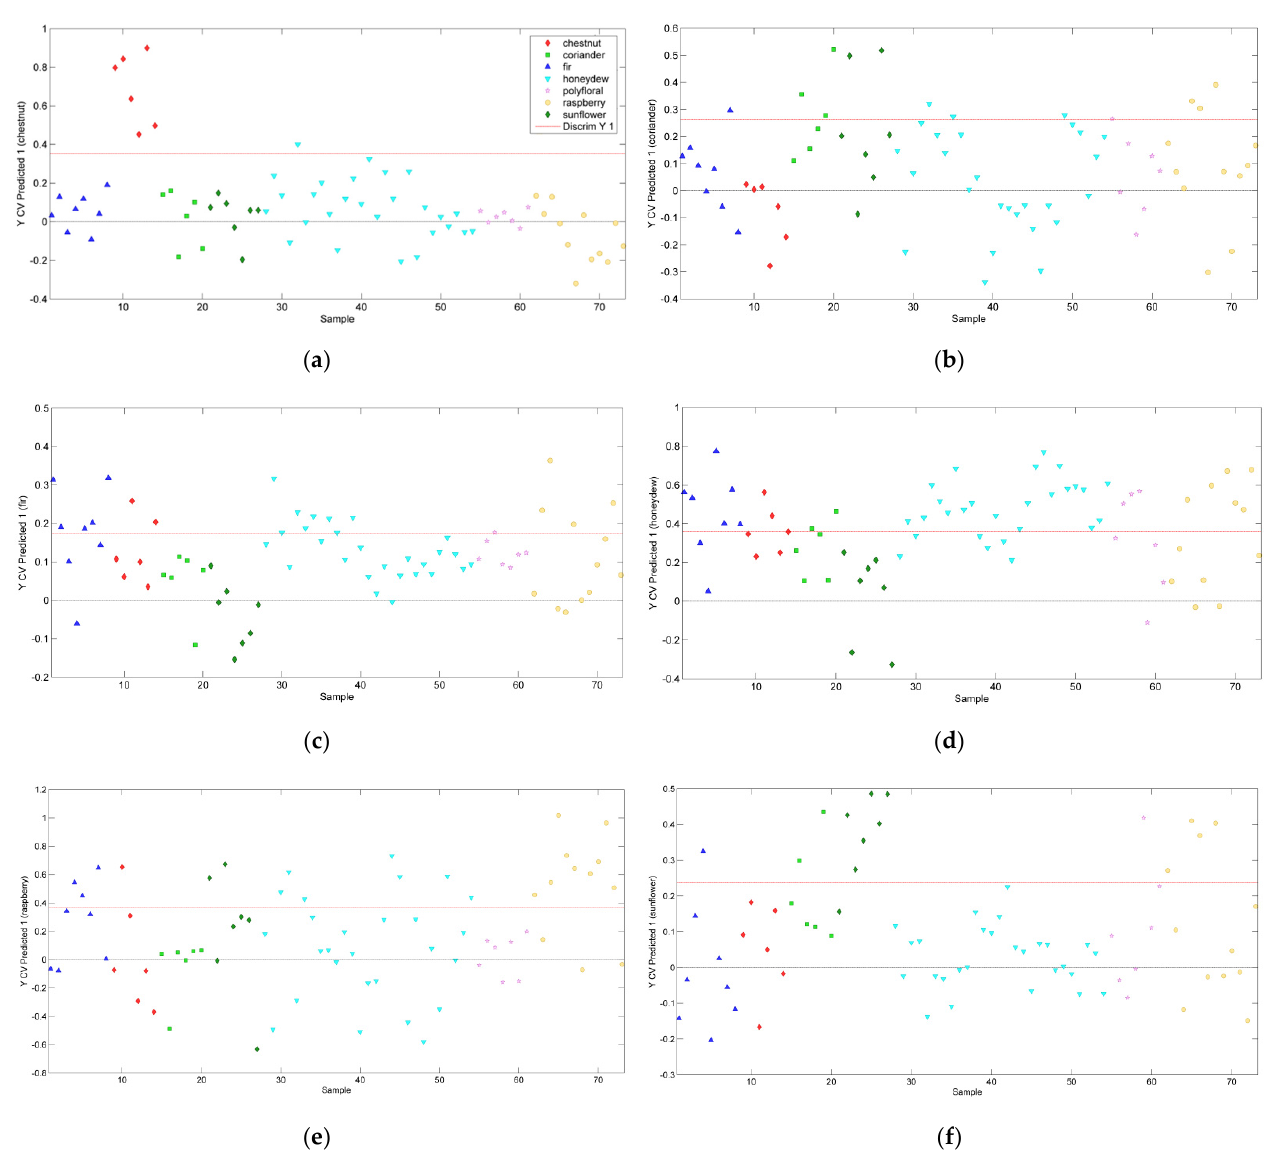
Figure 3. PLS-DA analysis—predicted Y values in cross-validation, for each of the investigated botanical differentiations: ( a ) chestnut, ( b ) coriander, ( c ) fir, ( d ) honeydew, ( e ) raspberry, and ( f ) sunflower.